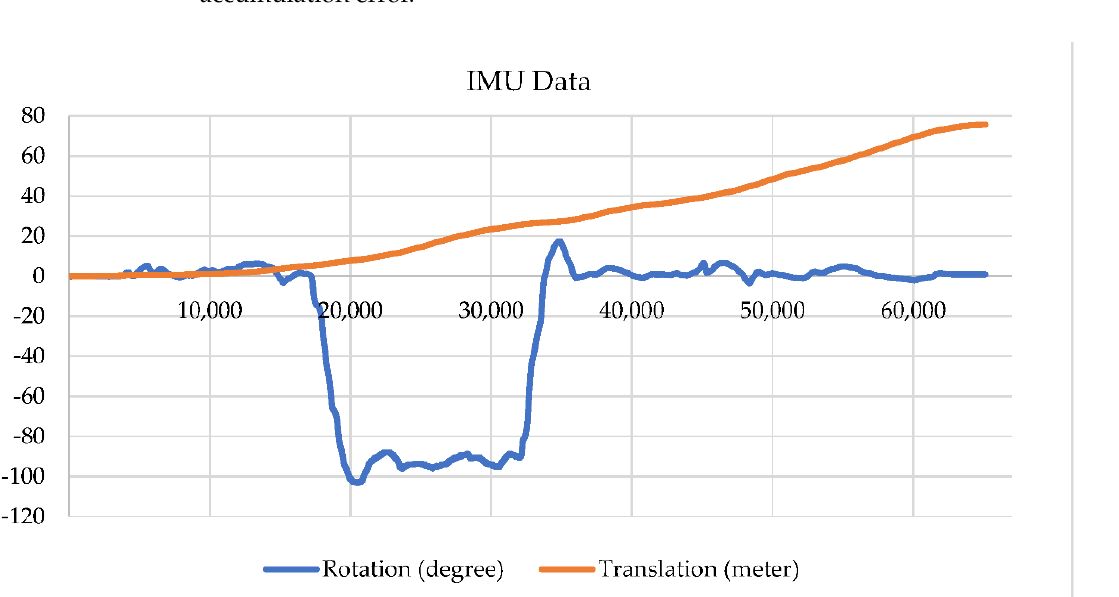
Figure 15. IMR rotation detected by e-SLAM.